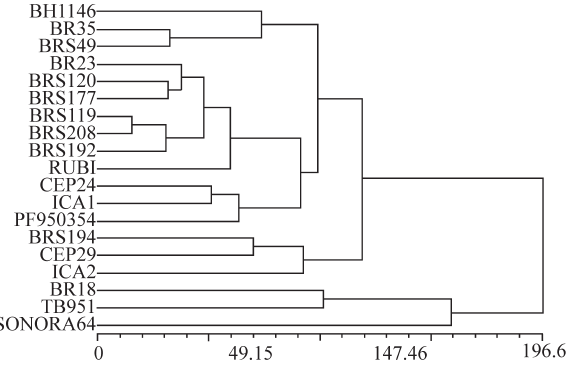
Figure 1 - Morphological character unweighted pair group method with arithmeticmeans(UPGMA)dendrogramresultingfromtheanalysisof19 wheat genotypes using the Mahalanobis distance based on 17 phenotypic characters as a measure of genetic distance. The value of the cophenetic correlation coefficient (r) was